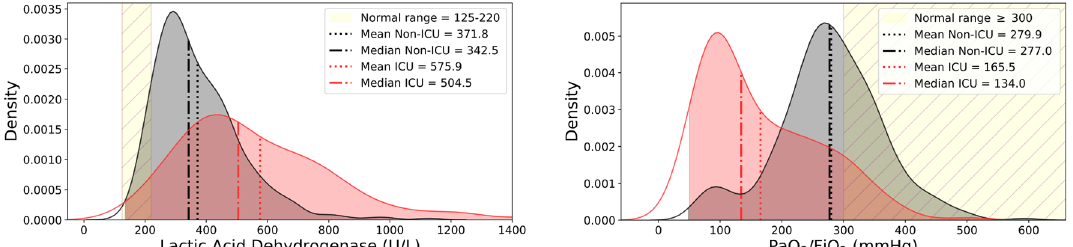
Figure 3. Distributions of Lactic Acid Dehydrogenase and P aO 2 / FiO 2 for patients in Non-ICU (grey) and ICU (red) severity classes. Yellow area is normal value range. Mean and median values are also indicated. LDH is an effective inflammatory biomarker. PaO 2 / FiO 2 is a biomarker of lung